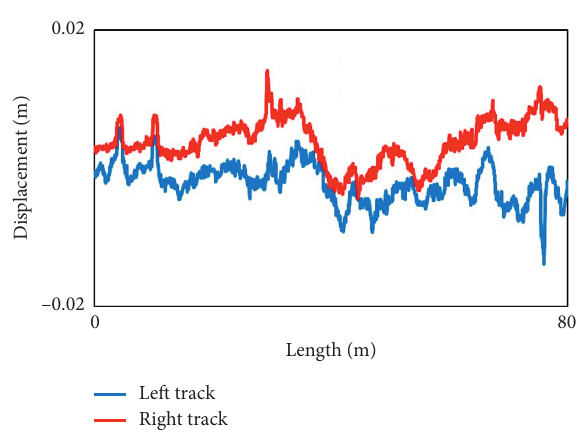
Figure 4: Road roughness of 80m length. Table 1: Comparison of vibrations r.m.s. at cab and carriage of 15-, 16- and 17-DOF